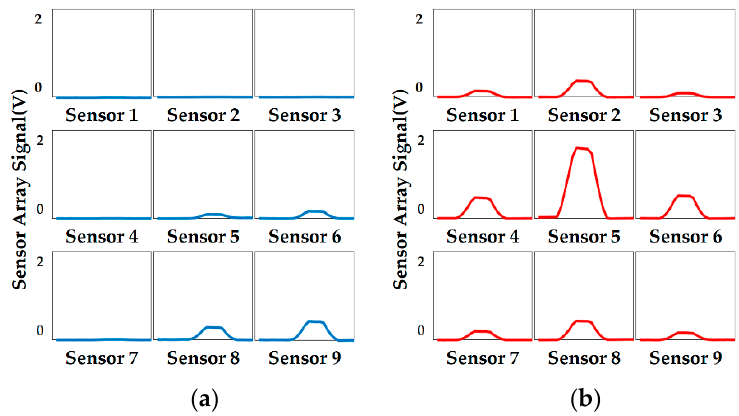
Figure 10. Output data of the sensor array using a sphere sample: ( a ) the curvature radius is 5 mm and the loading position in lower right corner of Figure 9a; ( b ) the curvature radius is 15 mm and the loading position is in the center of Figure 9a.